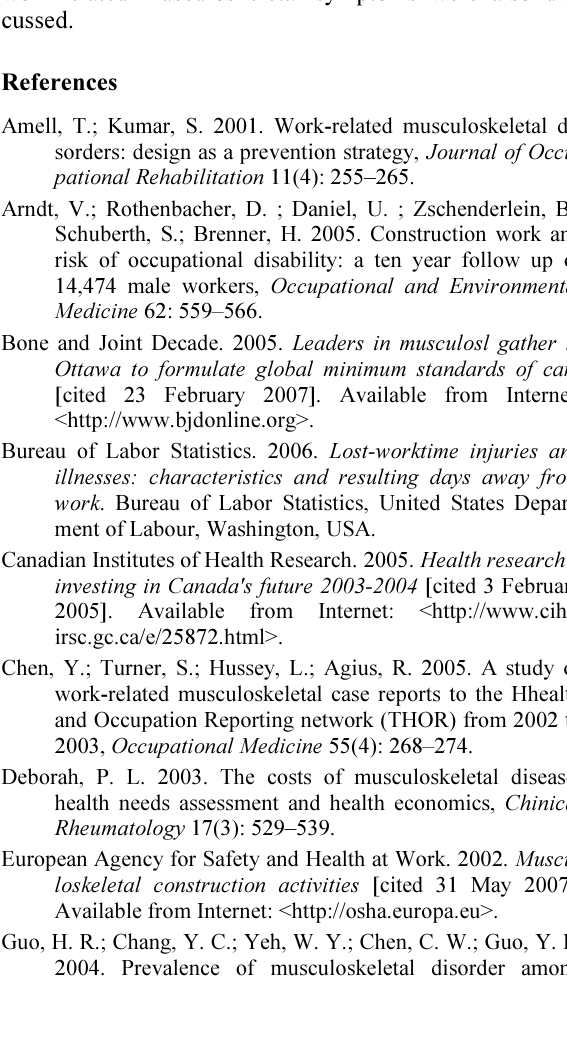
workers, practically in their upper extremities and lower back. All respondents reported that they had experienced at least one musculoskeletal symptom in the 11 body locations including neck, shoulder, upper back, upper arm, elbow, forearm, wrist, lower back, hip, knee, and ankle. Recommendations to reduce problems occurred for work-related musculoskeletal symptoms were also dis-